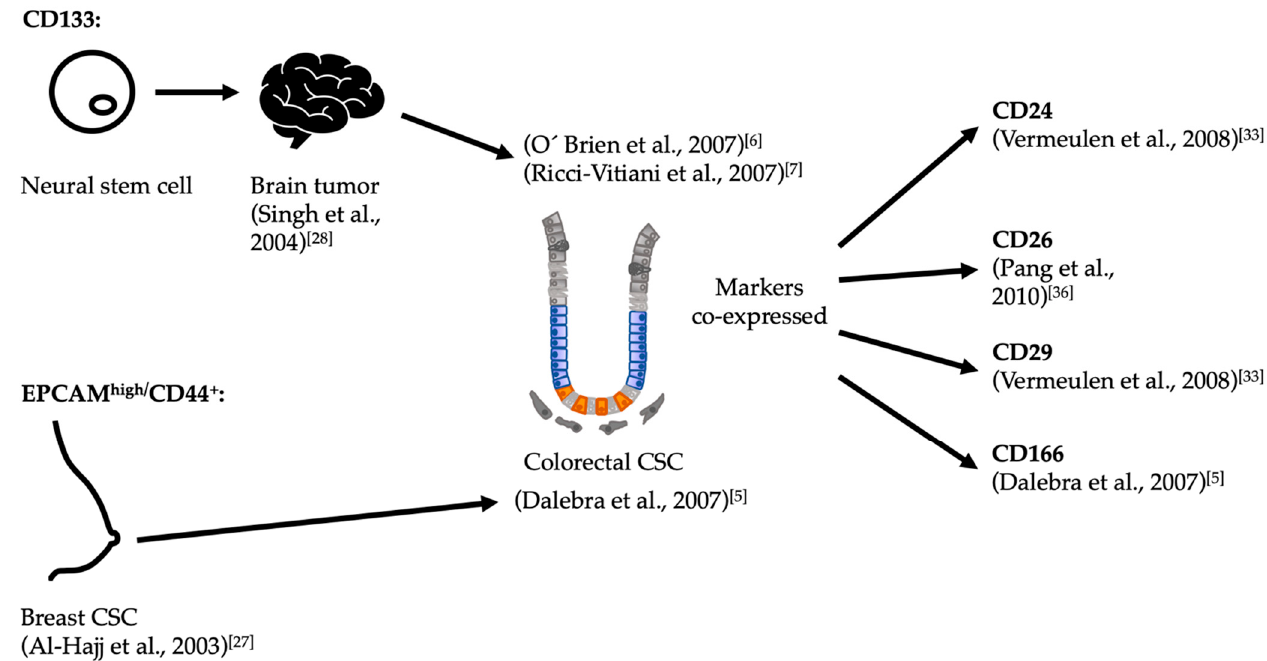
Figure 2. Historical development of CSC markers for colorectal cancer. In papers published back-to-back, O’Brien as well as Ricci-Vitiani and colleagues identified CD133 + colorectal cells as possessing tumor initiation capabilities upon heterotopic xenografts [6,7]. The criterion to probe this marker was derived from a previous experience with brain tumors, which in turn had derived from its expression in neural stem cells [28]. In parallel, Dalebra and collaborators had similar results, using the combination of the markers EpCAM high /CD44 + in subcutaneous injections [5,36]. In their case, the criterion to probe these markers derived from their previous work identifying putative CSCs from breast tumors [27]. Since none of these markers are expressed solely in putative CSCs, other associated markers were identified in an attempt to increase the specificity of markers for CSCs upon use in combination CSC: Cancer stem cell.